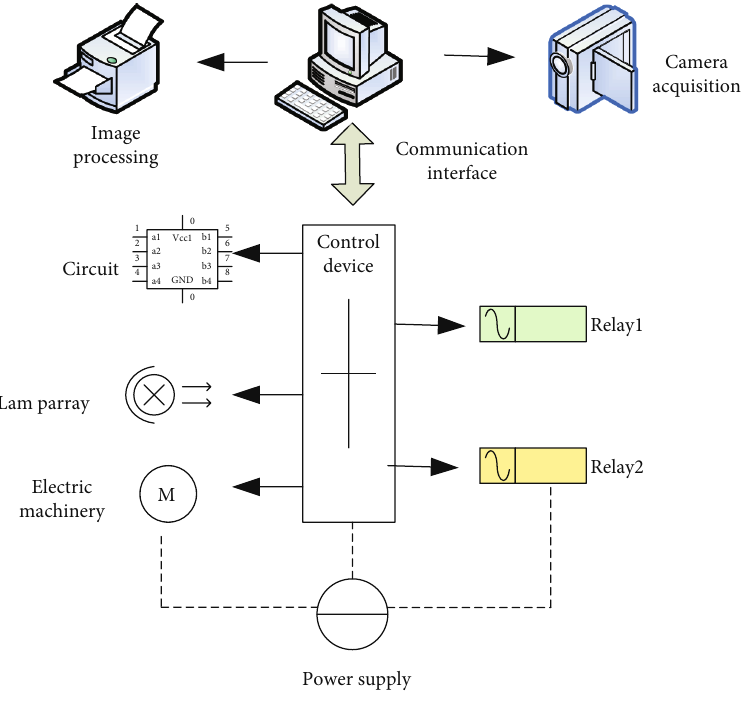
Figure 1: How colorimetric sensor arrays work.